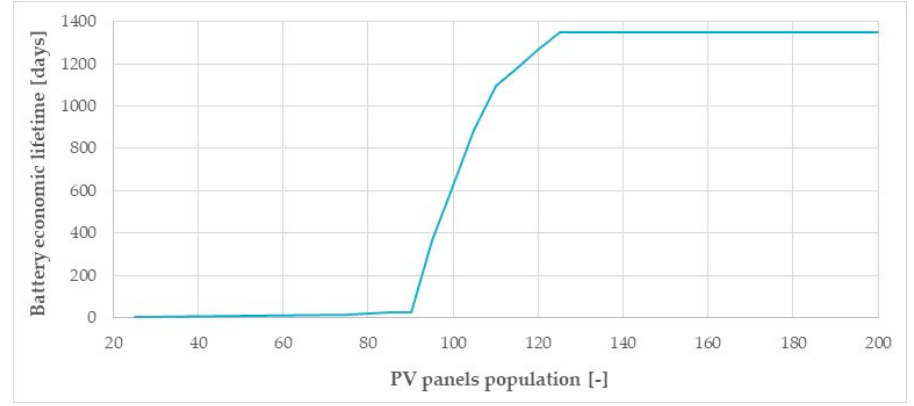
Figure 10. Battery economic lifetime for the SAPV system with respect to the PV population while the capacity of the 108 V AGM VRLA battery system is 2400 Ah.